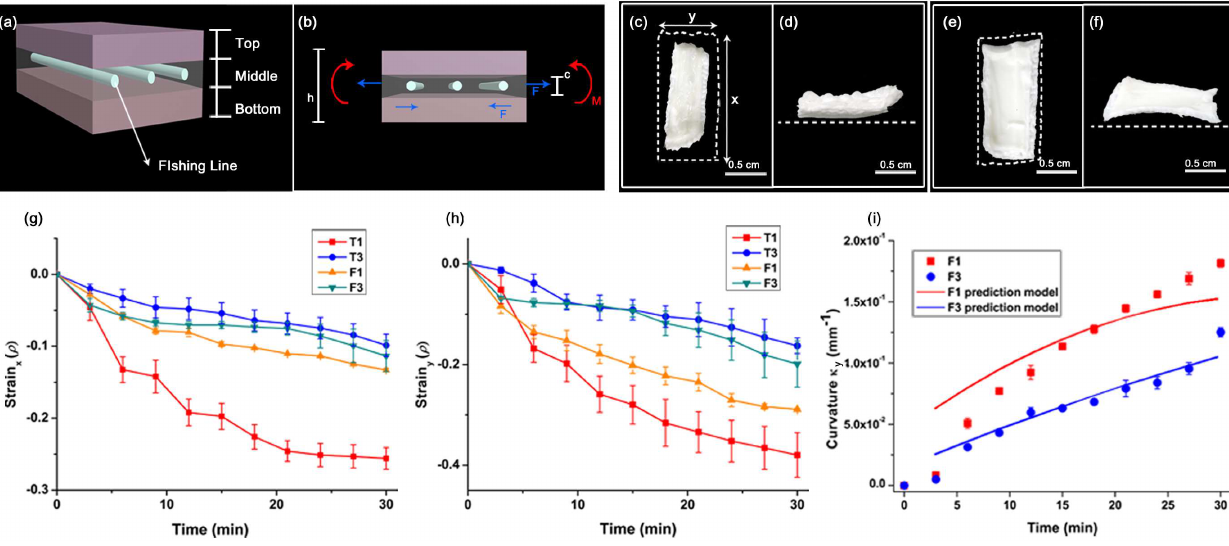
Fig 3. Homogeneous PNIPAAm with fibers show significant bending. (a) Schematicdiagram of the proposed PNIPAAm structure inspired by pine cone scale. Fishinglines are embedded in the middle layer representing fibers in the pine cone scales. (b) Schematic diagramfor a bimetallic theory considering the fiber constraint and the temperature gradient. In the diagram, h is the heightof the system, c is the thickness of the part constrained by fishinglines, and F 1 , F 2 and M are the internalforces and torque caused by the temperature gradient. The middleand the bottom parts are in highertemperature than the top part. (c-f) Structural changescaused by heatingof F1 (triple layer with fishinglines and C1) and F3 (triple layer with fishinglines and 3 mg cross linker). ( c ) White dash lines indicate the initial size of the structure. After heating, F1 mainly shrinks in y-direction.( d ) Instead of shrinkagein x-direction,the side view shows upwardlifting motion of F1 layers. ( e ) F3 structure slightly shrinks from its initial size (white dash lines). ( f ) F3 exhibits significantbendingmotion, like F1 structure. Strain changesin the x-direction(parallelto fiber direction) (g) and in the y-direction(perpendicular to fiber directionand the temperature gradientdirection) (h) depictedas graphs. Due to the support of the fishing line in the x-direction, the strain change with temperature of F1 is much less than that of T3. (i) The curvature in the directionparallelto the fibers can be qualitativelyexplainedby a bimetallic theory combiningthe fiber constraint and the temperature gradient. Dot: experimental measuredcurvature of PNIPAAm layer with fishinglines (square: F1, circle: F3) in y-direction over time. Line: theoretical predictionwith linearized contractionmeasurement on PNIPAAm layers without fishing lines (T1, T3). The thickness of the fiber-constrained layer c fitted from the curvature data are 0.9 mm for F1 and 0.67 mm for F3, comparedto the height 1.5 mm of both